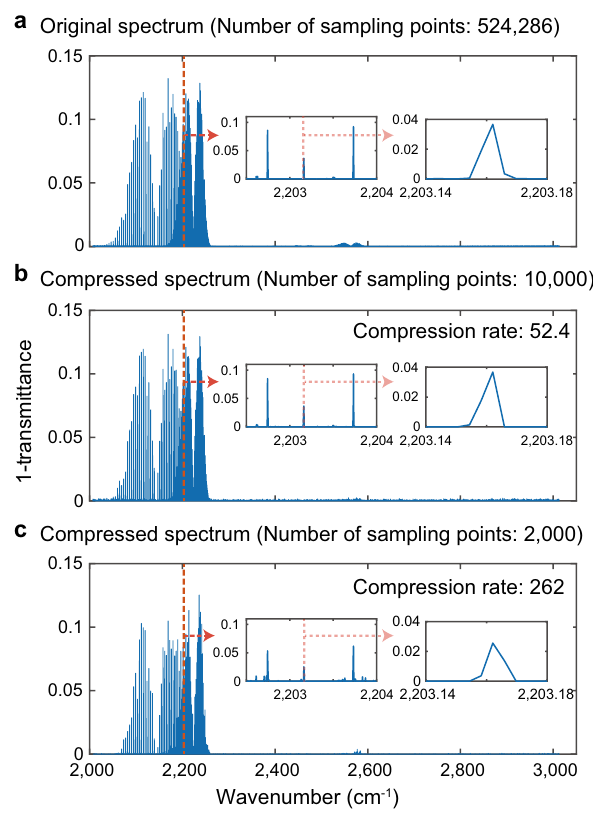
Figure 2. Simulated MIR DCS spectra of gaseous molecules. ( a ) An original spectrum Fourier-transformed by temporal data points of 524,286. ( b , c ) Compressed spectra with 10,000 and 2000 sampling points, respectively. The inset panels show zoom-in spectra around 2203 cm −1